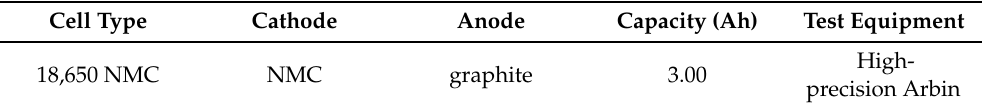
Table 1. Sandia National Laboratories equipment for cycle aging experiments [52].